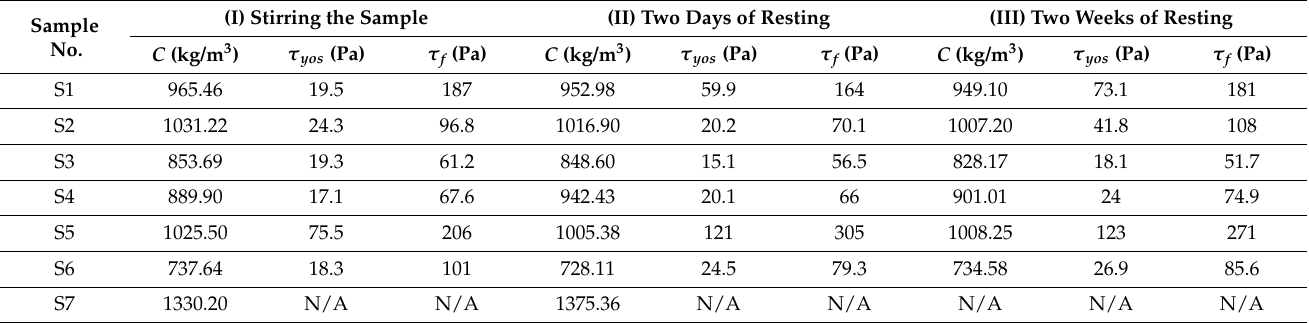
Table 6. Obtained yield and flow-point stress values from oscillatory test results for three steps.